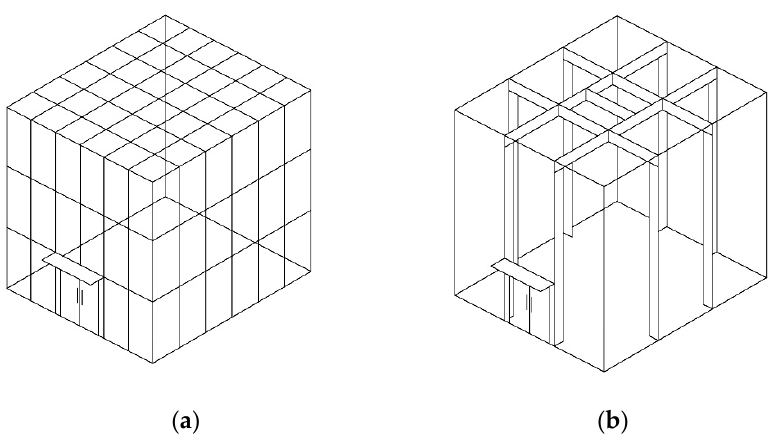
Figure 12. Glass Apple Fifth Avenue Cube: ( a ) 2006 version; ( b ) 2011 version (figures by the